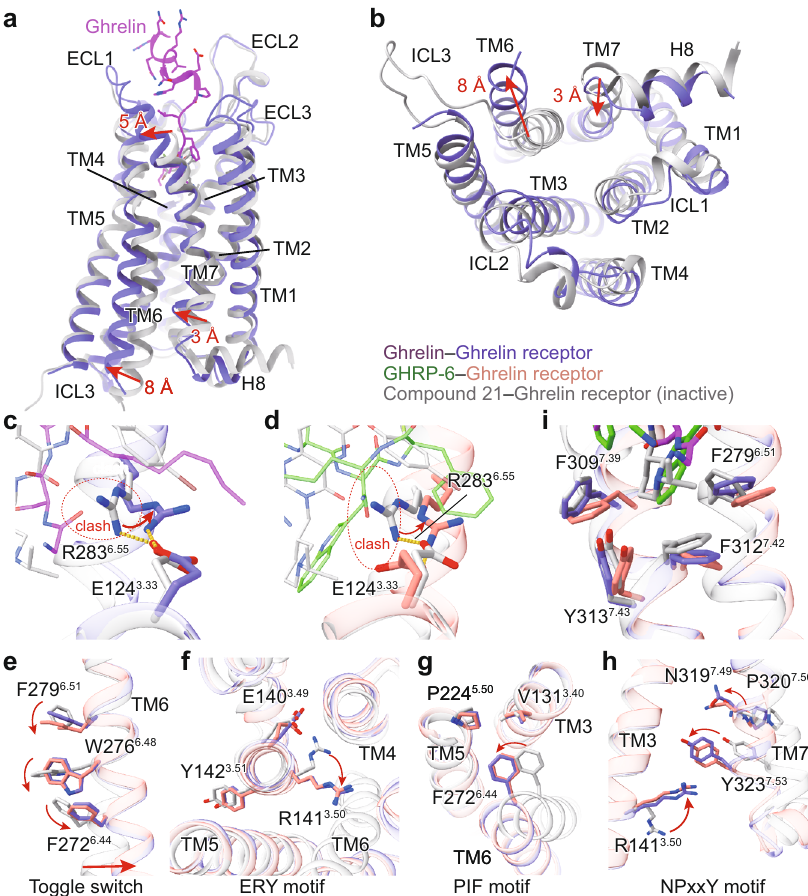
Fig. 4 Activation mechanism of ghrelin receptor. a , b Structural superposition of the active and antagonist-bound ghrelin receptor. ( a ) side view; ( b ) cytoplasmic view. c , d Conformational changes of the salt bridge comprising of E124 3.33 and R283 6.55 upon peptide activation. Ghrelin and GHRP-6 push the side-chain of R283 6.55 to swing away from the receptor helical core due to steric clash. The swing orientations of E124 3.33 and R283 6.55 were indicated by red arrows. The clashes were highlighted as red oval dashed lines. e-h Conformational changes of the conserved “ micro-switches ” upon receptor activation. ( e ) Toggle switch, ( f ) ERY motif, ( g ) PIF motif, ( h ) NPxxY motif. The outward displacement of TM6 of the active receptor is shown as a red arrow ( e ). The conformational changes of residue side chains are shown as red arrows upon receptor activation. i The hydrophobic cluster comprising F279 6.51 , F309 7.39 , F312 7.42 , and Y313 7.43 stabilizes the inter-helical hydrophobic contacts between TM6 and TM7. Ghrelin is shown in magenta, ghrelin- bound ghrelin receptor in slate blue. GHRP-6 is displayed in green, and GHRP-6 bound ghrelin receptor in salmon. The compound 21-bound ghrelin receptor (PDB: 6KO5), is colored in